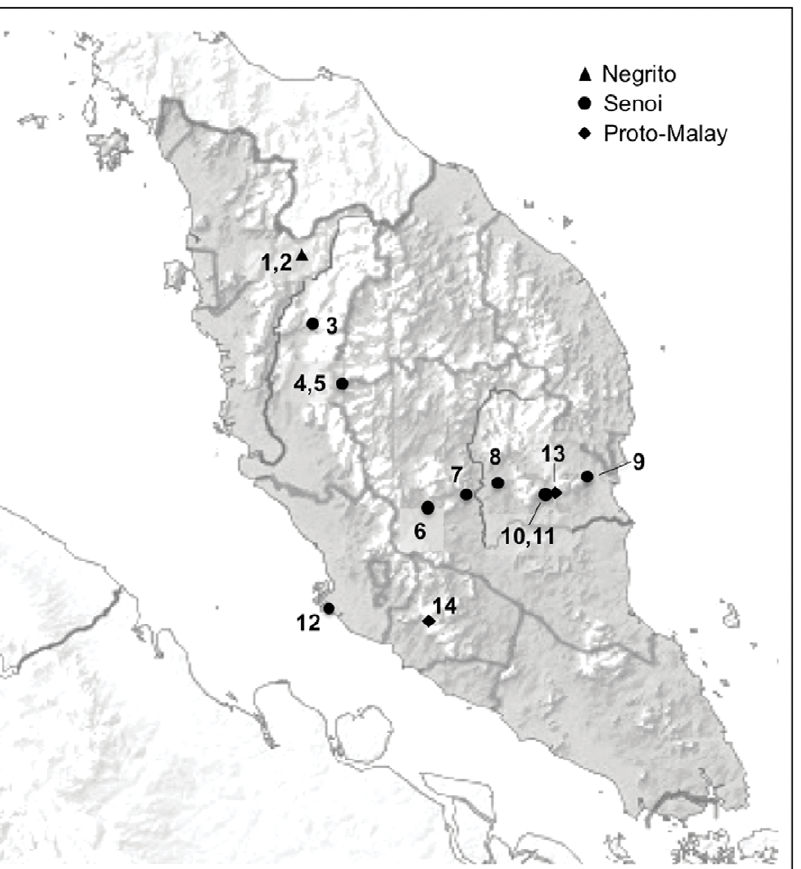
Figure 1. Map of Peninsular Malaysia indicating sampling sites. For Orang Asli tribes and their corresponding village locations, see Table S1. doi:10.1371/journal.pone.0042752.g001 PLOS ONE |